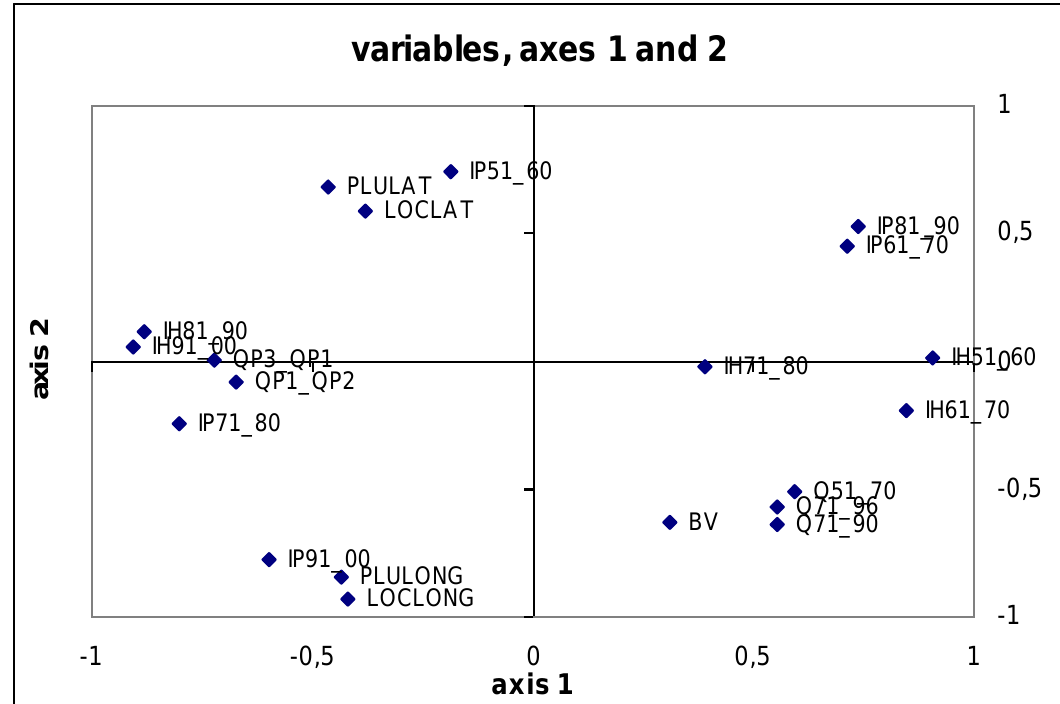
Figure 14. Variables space of the PCA, axes 1 and 2. variables, axes 1 and